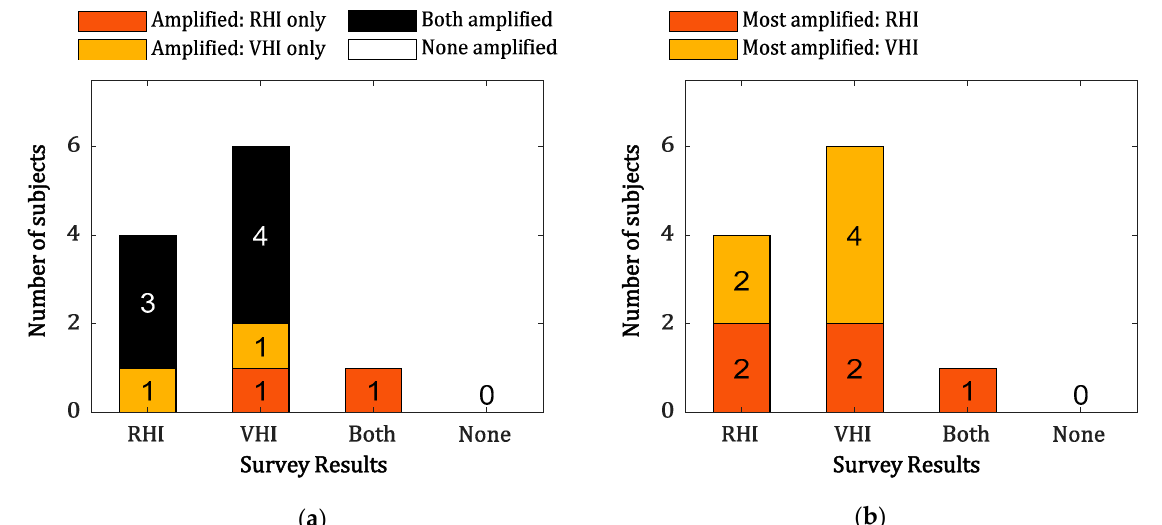
Figure 6. Survey results for each paradigm: ( a ) Amplified MI guidance system vs. MI-P; ( b ) Most amplified MI guidance system. The black block represents the subjects with MI ERD enhancement in both paradigms, while the red and yellow blocks represent the subjects with enhancement in RHI-P and VHI-P, respectively.